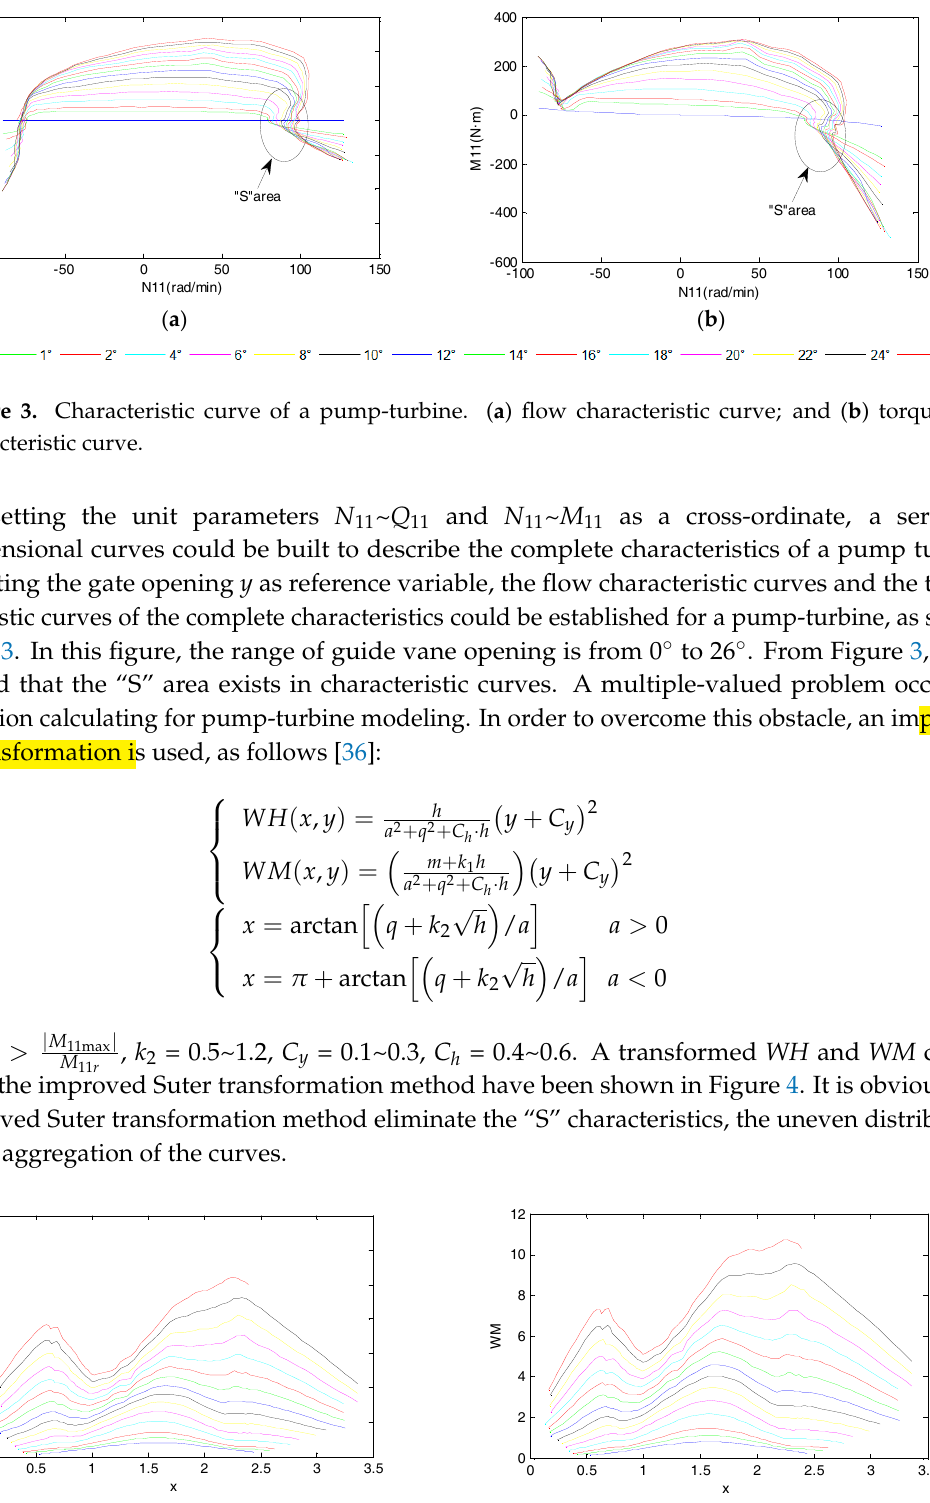
Figure 4. The WH and WM curves transformed by the improved Suter transformation method.